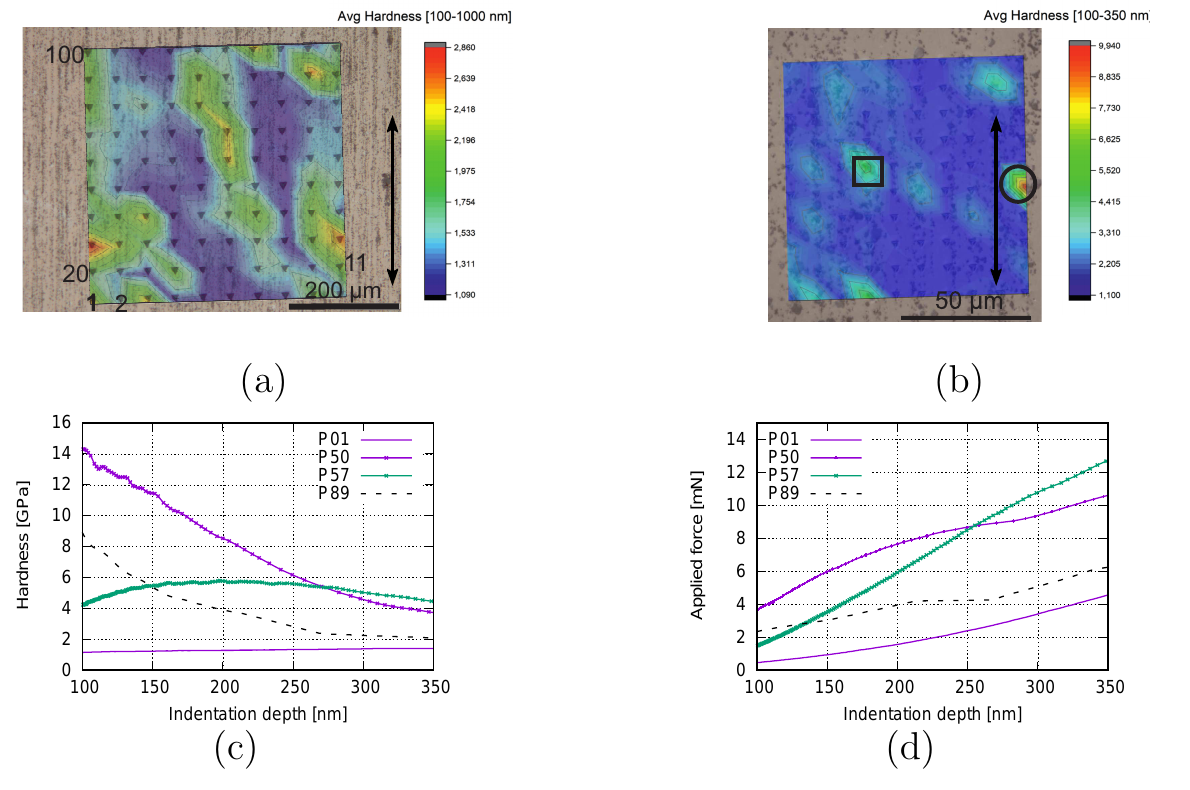
Fig. 3: The nanoindentation measurement (HV0.3) of PM 12-2 MMC in the longitudinal section (100 measured points): ( a ) averaged values with 50 µ m distance between two neighboring points and the arrow presenting the extrusion direction; ( b ) averaged values with 10 µ m distance between two neighbor points and the arrow presenting the extrusion direction; ( c ) hardness value evolution according to indentation depth for some selected points in ( b ); ( d ) same as ( c ), but for applied forces.